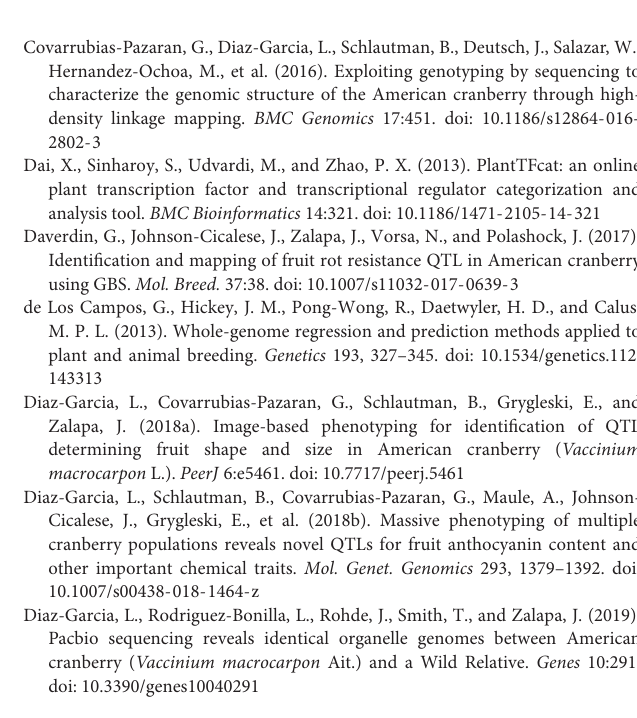
Supplementary Figure 1 | Plant material, sequencing resources, and methods for sequence data generation, assembly, polishing, and scaffolding of the cranberry and Vaccinium microcarpum genome assemblies. Supplementary Figure 2 | Parental linkage maps for the CNJ02 and GRYG